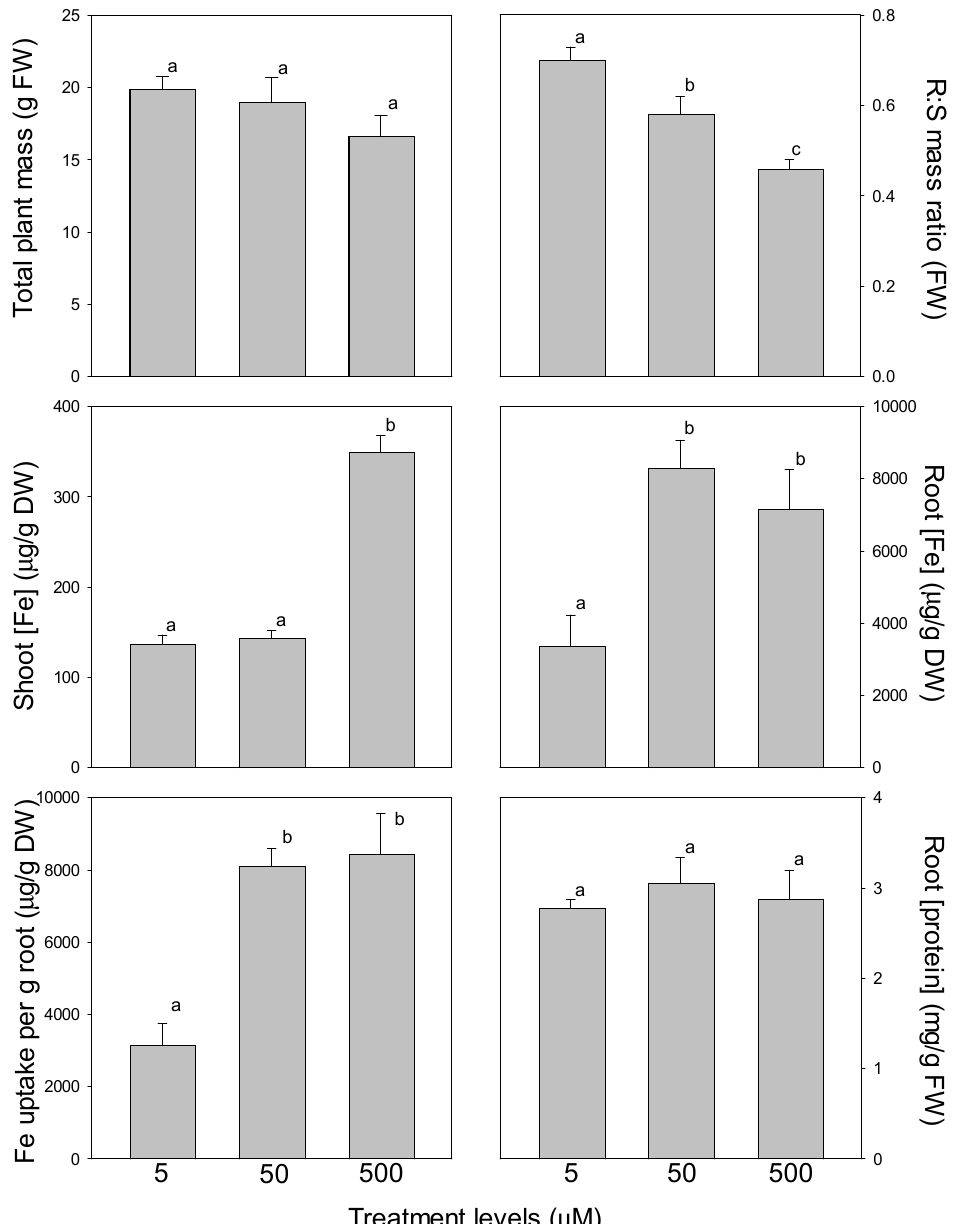
Figure 2. Effects of variation in Fe availability in marigold on total plant fresh mass (FW), root-to- shoot fresh-mass ratio, shoot and root Fe concentration (dry mass basis, DW), Fe uptake per g root; (= total plant Fe per g root, dry mass basis), and root protein concentration (fresh mass basis). Results are means + 1 SE; letters above bars indicate comparisons among treatments (different letters indicate significant differences at p < 0.05).